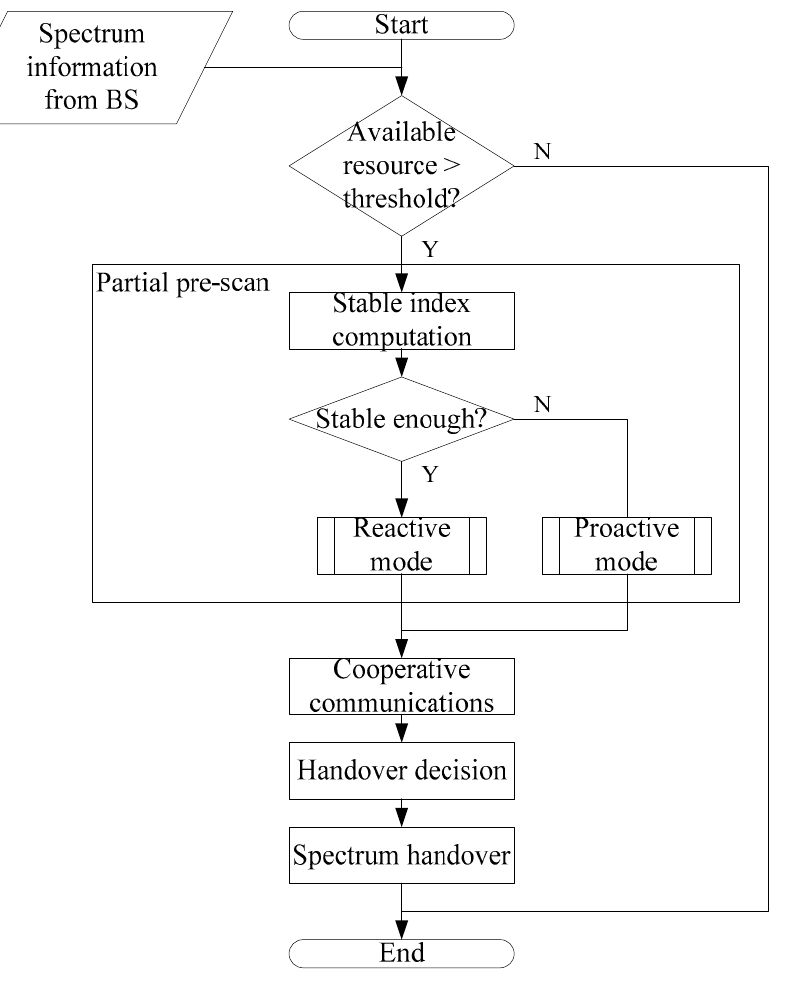
Figure 9. The flow chart of CASH.